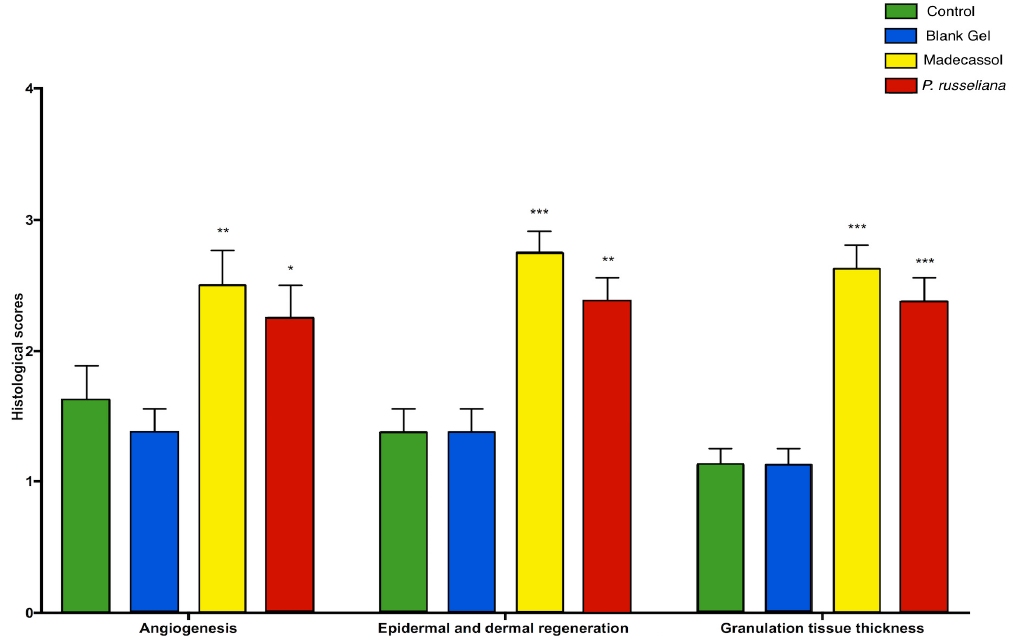
Figure 7. Histological granulation scores; tissue thickness, angiogenesis, and epidermal–dermal regeneration of control, blank gel, Madecassol, P. russeliana extract gel groups. Statistically significant compared to control groups; * p < 0.05, ** p < 0.01, *** p < 0.001.